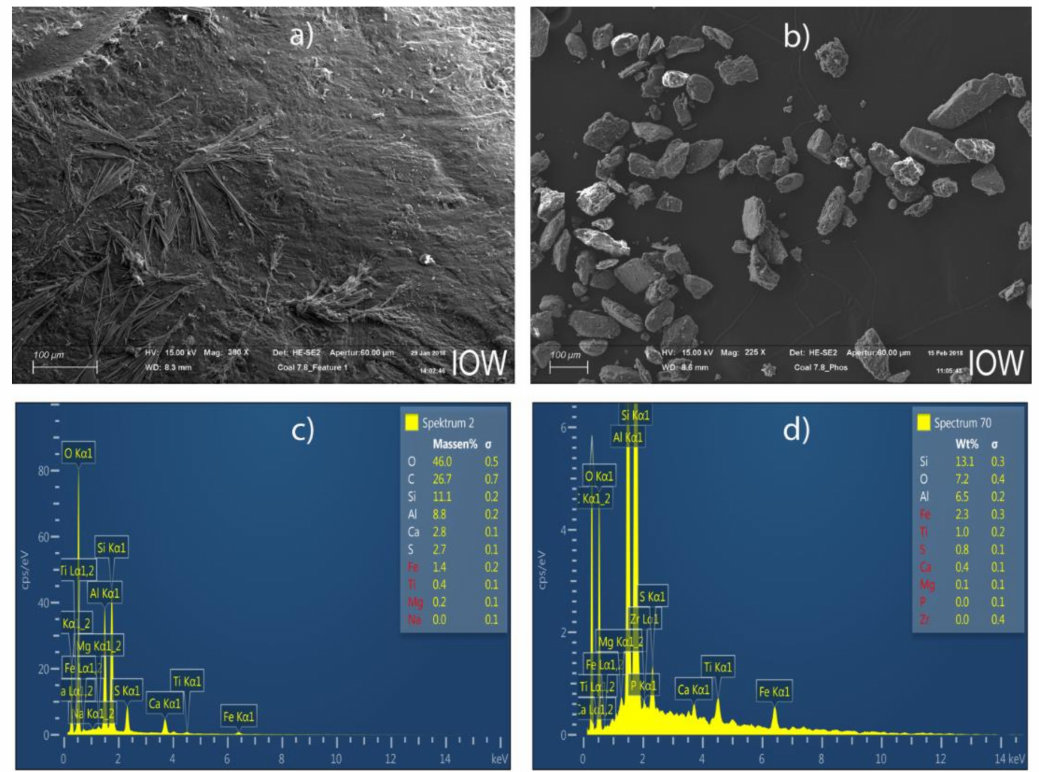
Figure 1. Scanning electron microscope (SEM) images ( a ) before adsorption, ( b ) after adsorption; energy dispersive X-ray (EDX) elemental spectra ( c ) before adsorption and ( d ) after